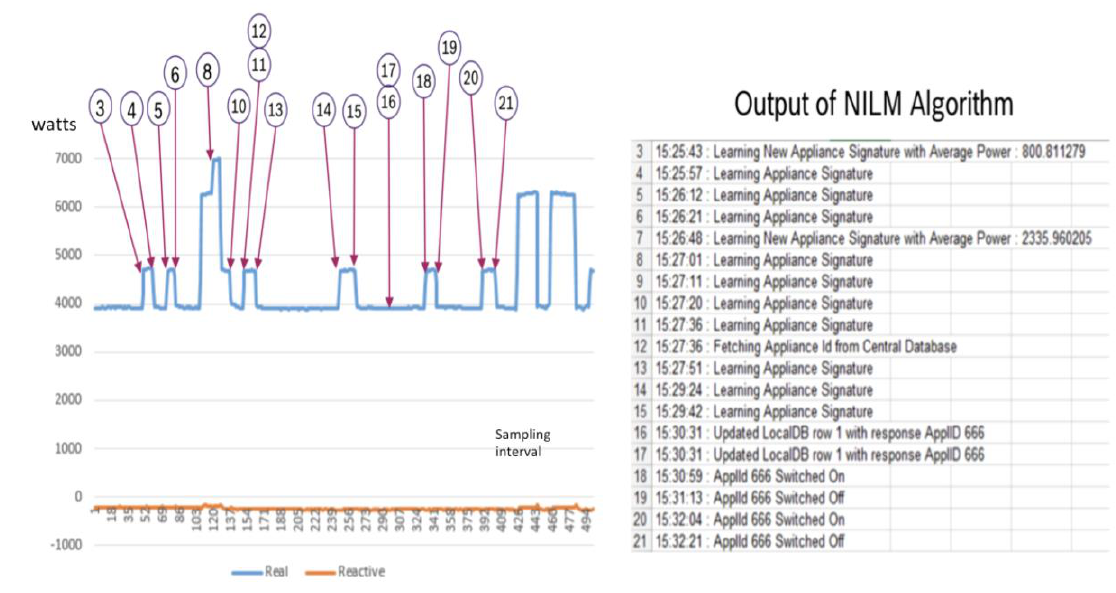
Figure 12. NILM learns new signatures of load appliances.